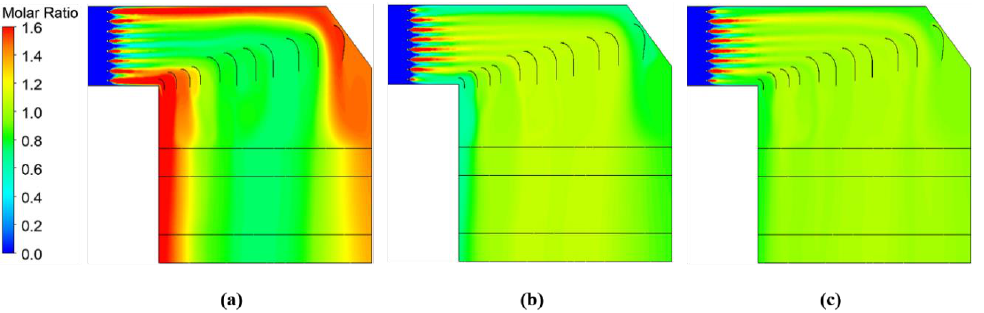
was found between constant injection and optimization injection.